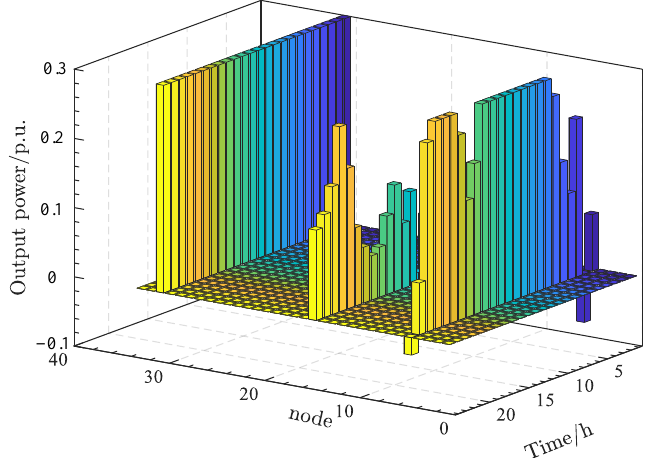
Figure 12. SVC Spatial and temporal distribution of power output.